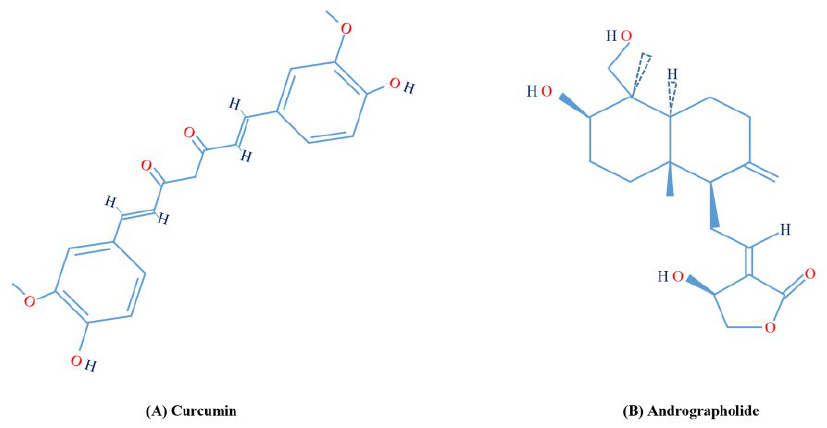
Figure 1. Chemical structures of ( A ) curcumin and ( B ) andrographolide.